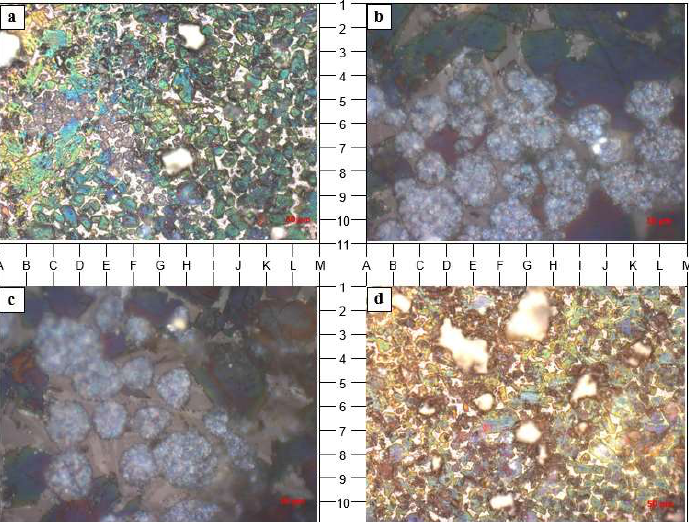
Figure 6. Microphotographs representing the morphology of the belit crystals present in the clinker nodules. Enlarge images: ( a , d ) M200X; ( b , c ) M1000X; ( d ) secondary belit for alite crystals.